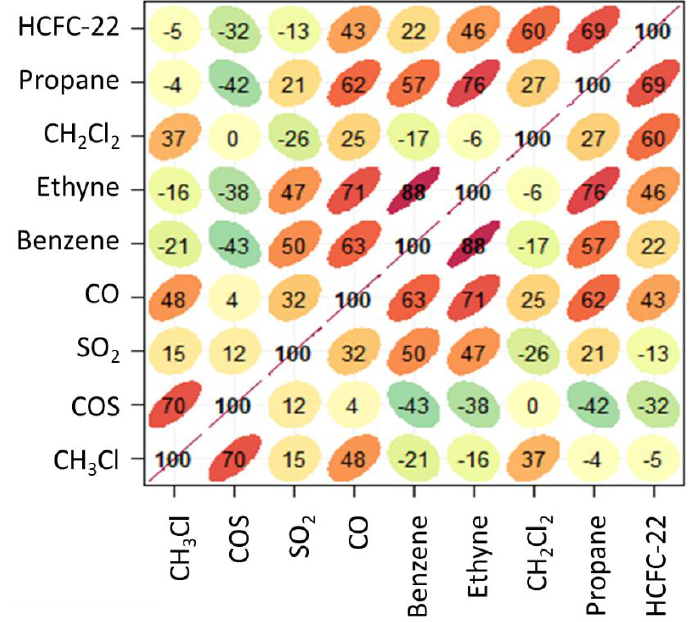
Figure 5. Multiple correlation analysis of the smoothed dataset for summer 2017. The shape of ellipses provides a visual representation of the scatter plot for each couple of variables, the numbers and the colour code give representation of the R value (green: negative slope of correlation, red: positive slope of correlation).